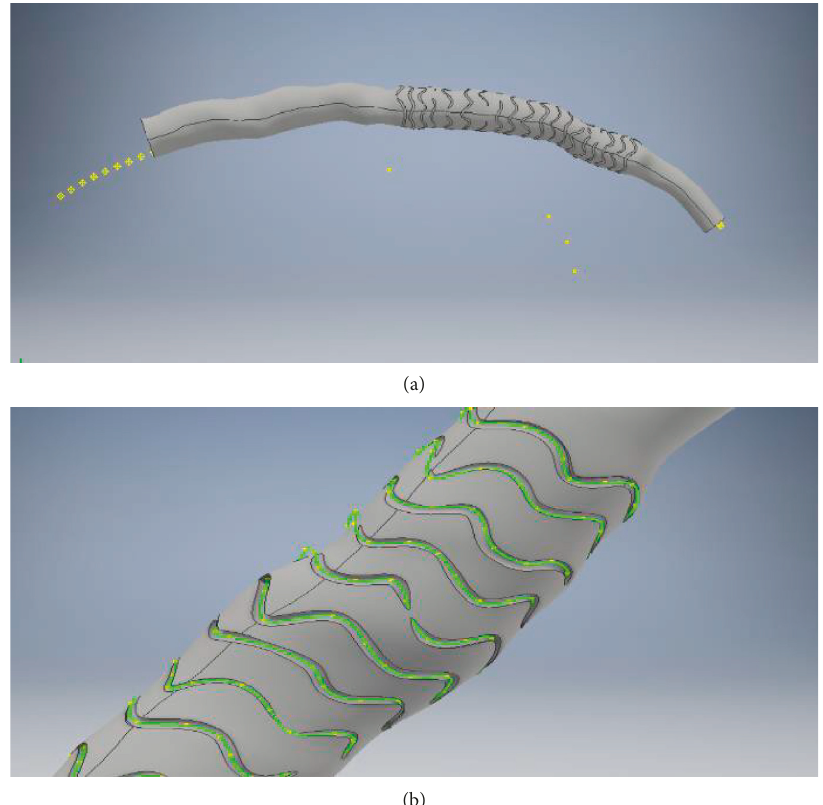
Figure 5: A three-dimensional model of a bioabsorbable stent with a corrugated surface (a) obtained by subtracting the three-dimensional model of the vessel from the stent